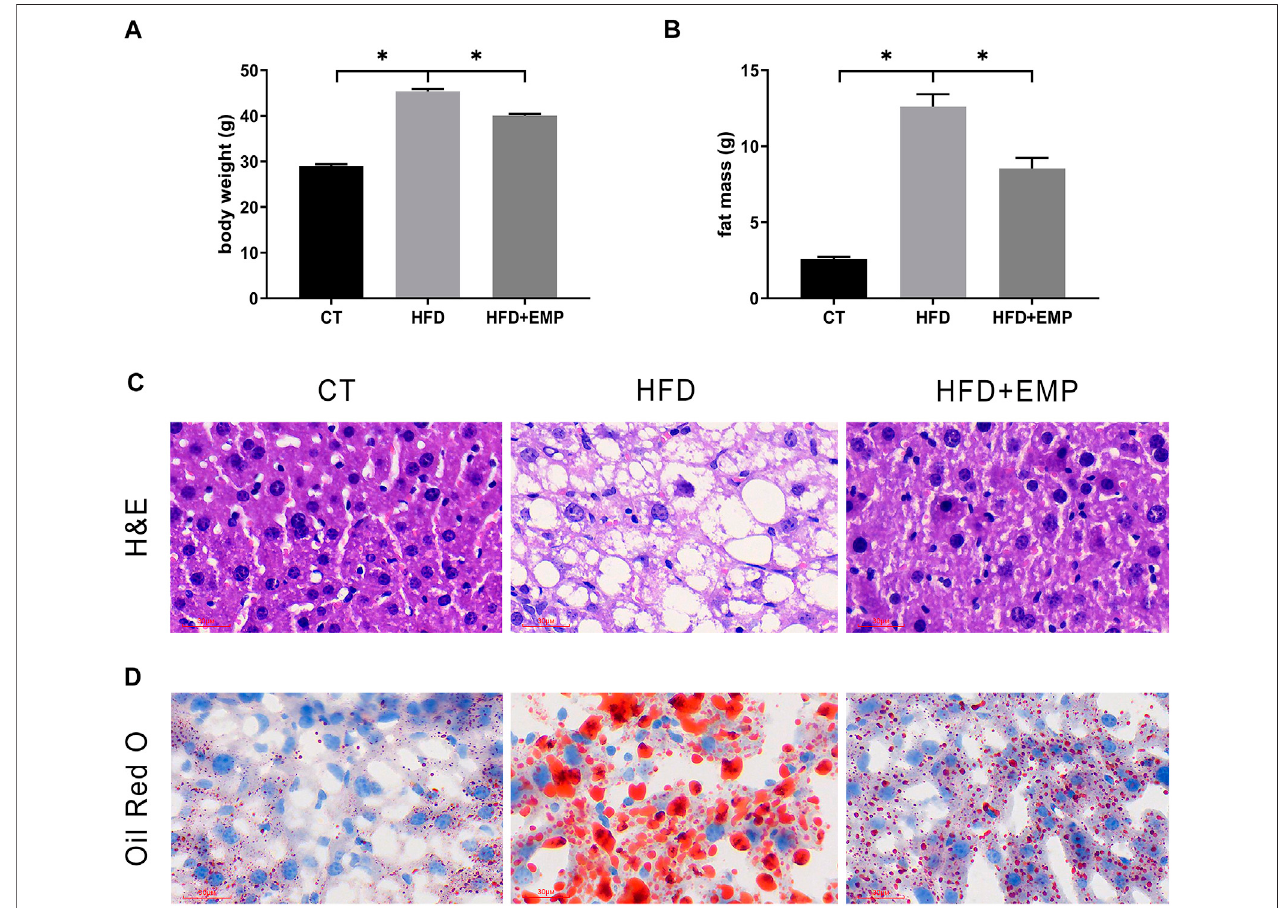
FIGURE 1 | Effect of EMP on mice. The impact of EMP on body weight (A) and fat mass (B) . Liver histological examination with H&E (200 × ) (C) and Oil Red O staining (D) . Data are presented as means ± SEM, * p < 0.05, Scale bar: 30 μ m.